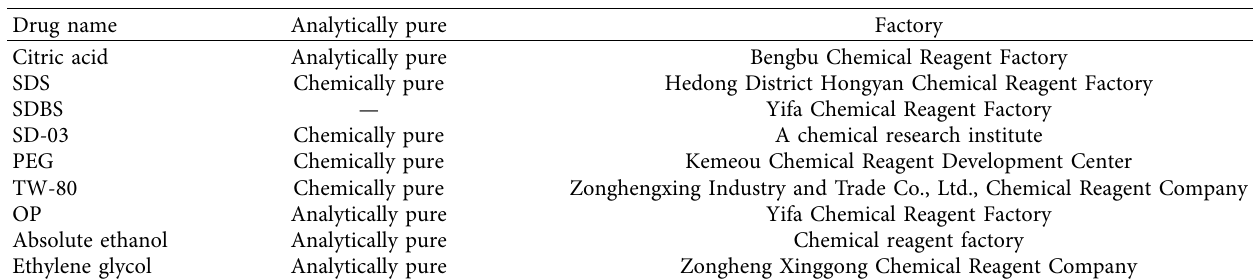
Table 1: Main reagent information.